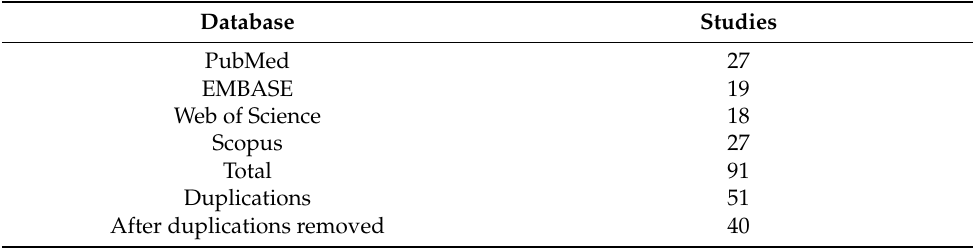
Table A1. Results of the search